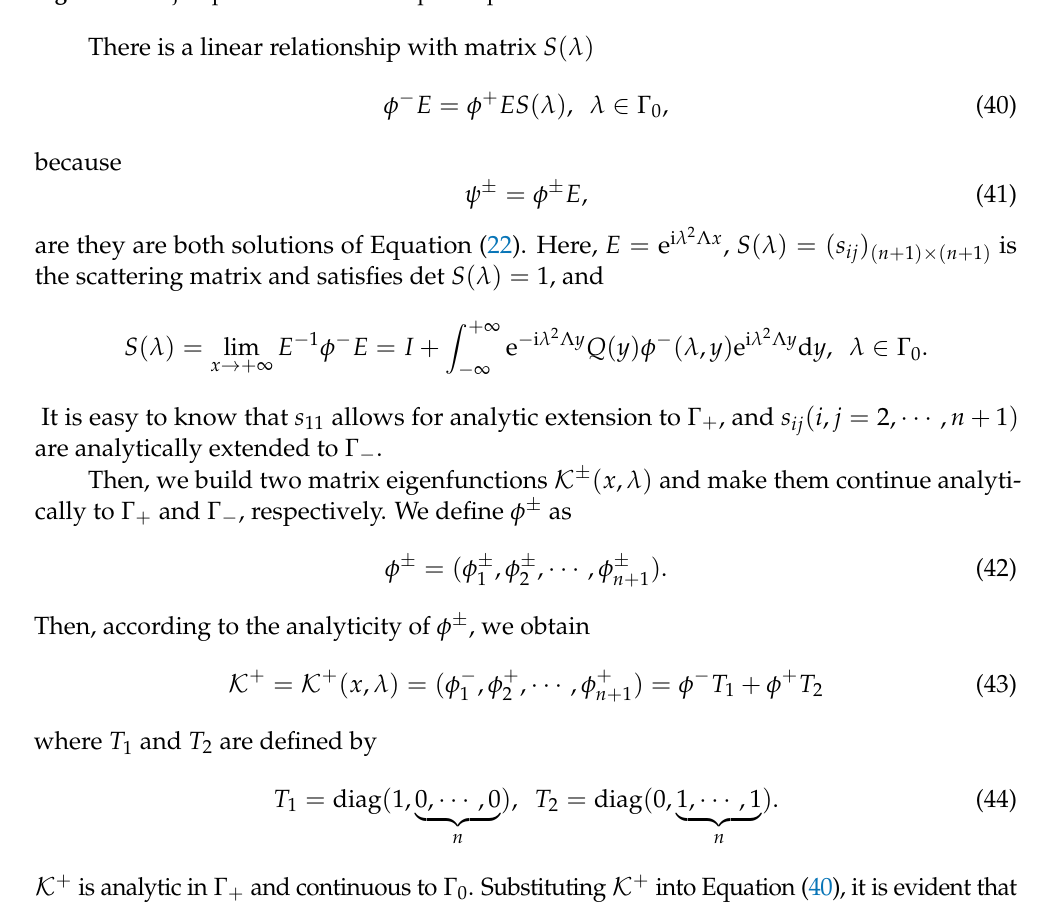
Figure 1. The jump contour in the complex λ